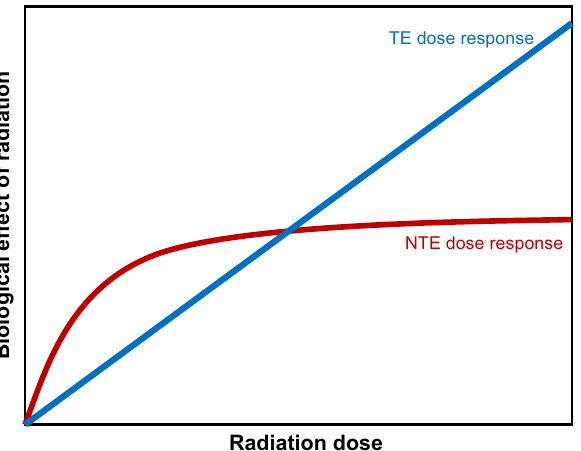
Figure 1. Schematic comparison of typical radiation dose response shapes for targeted effects (TE) and non- targeted effects